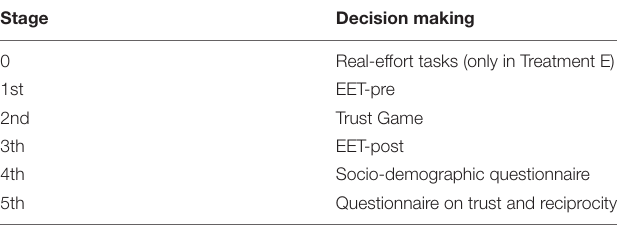
TABLE 2 | Structure of an experimental session.